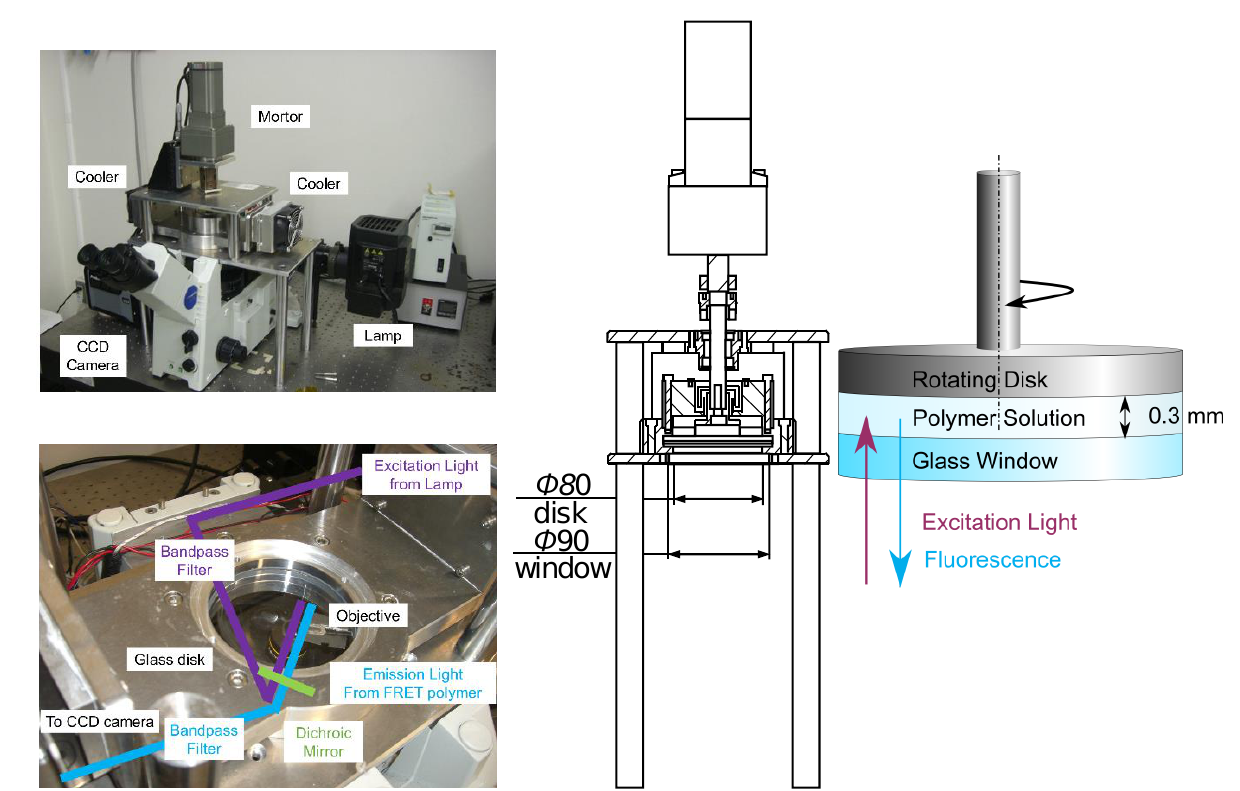
Figure 6. Schematics of the experimental setup.